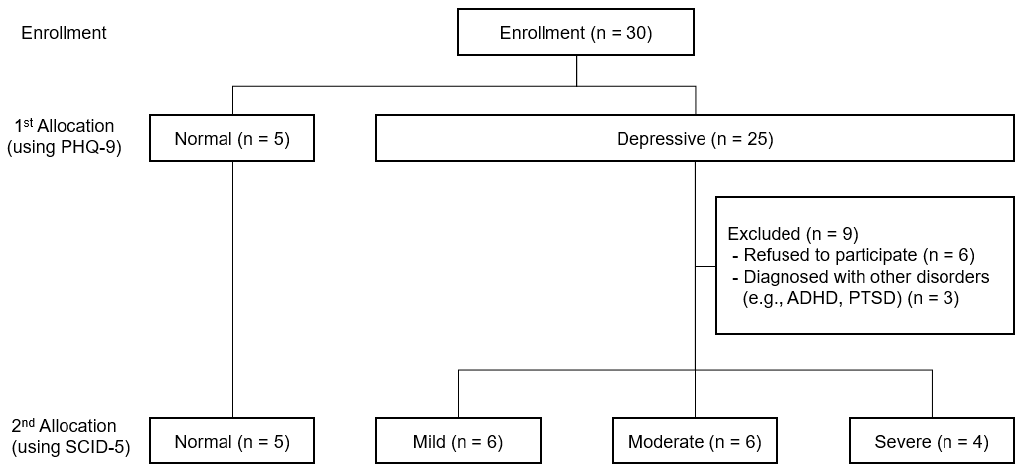
Figure 2. Consort flow diagram: recruitment phase.